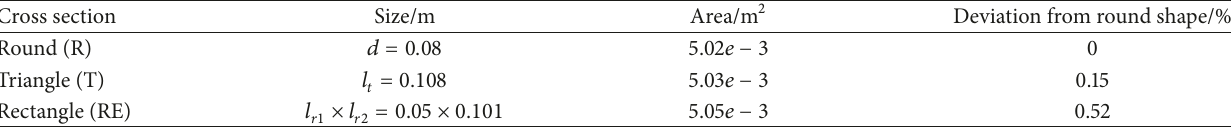
Figure 4: The impact of lifting velocity on angle of repose. Table 1: The cross-section parameters of three containers.